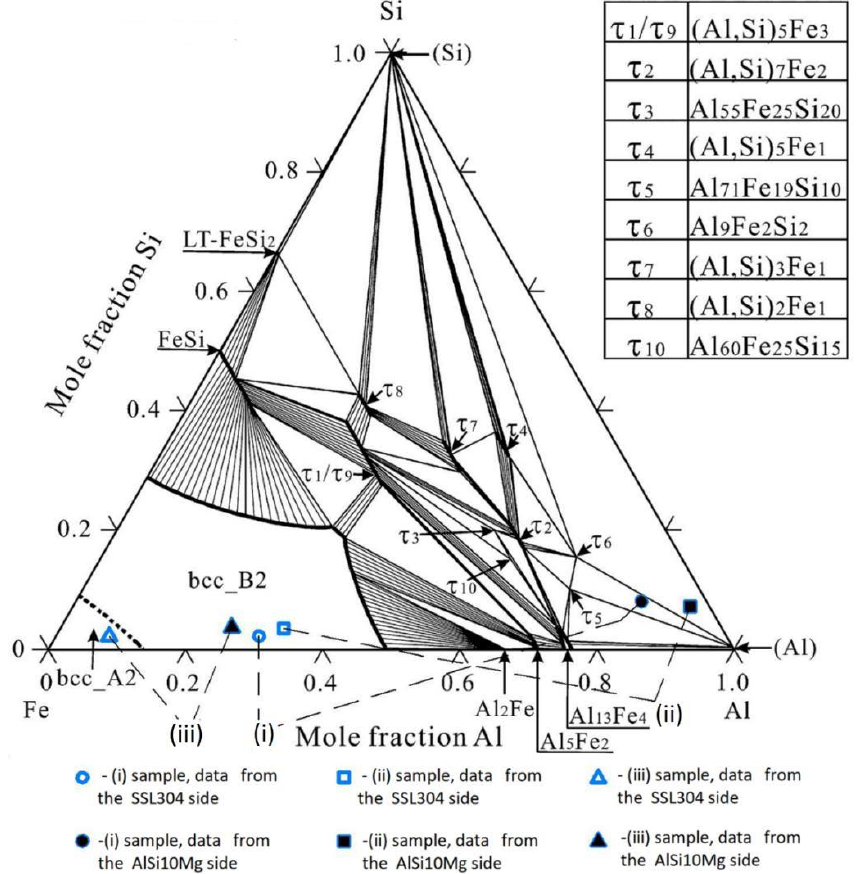
Figure 5. Ternary Fe-Al-Si phase equilibrium diagram at 550 °C isothermal section [35] (Reprinted with permission from Ref. [35] Elsevier 2021) with components from SS304L-AlSi10Mg interface (Figure 3); bcc_A2 and bcc_B2 are disordered and ordered BCC phases, respectively.